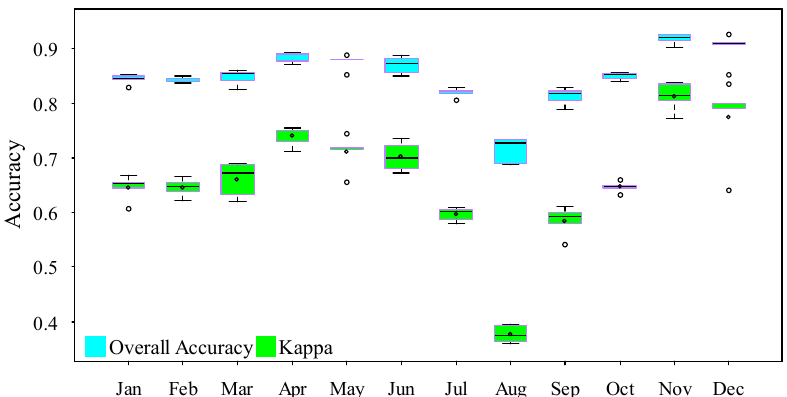
Figure 2. Summary statistics for the OA and Kappa coefficient of five classifiers, four OCCs, and the SVM, for different months.